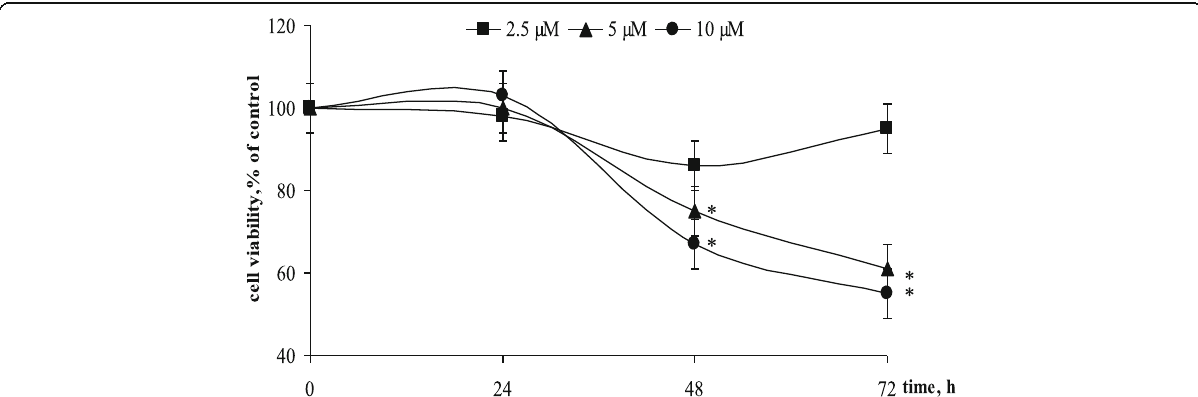
Fig. 5 Viability of CCRF-CEM cells incubated with diphenyl-N-(trichloroacetyl)-amidophosphate (HL) in different concentrations. (M ± m, n = 8); * p < 0.05 compared to control